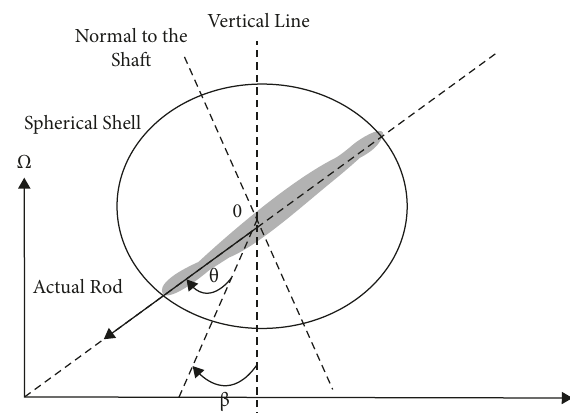
Figure 3: Rolling motion of a spherical